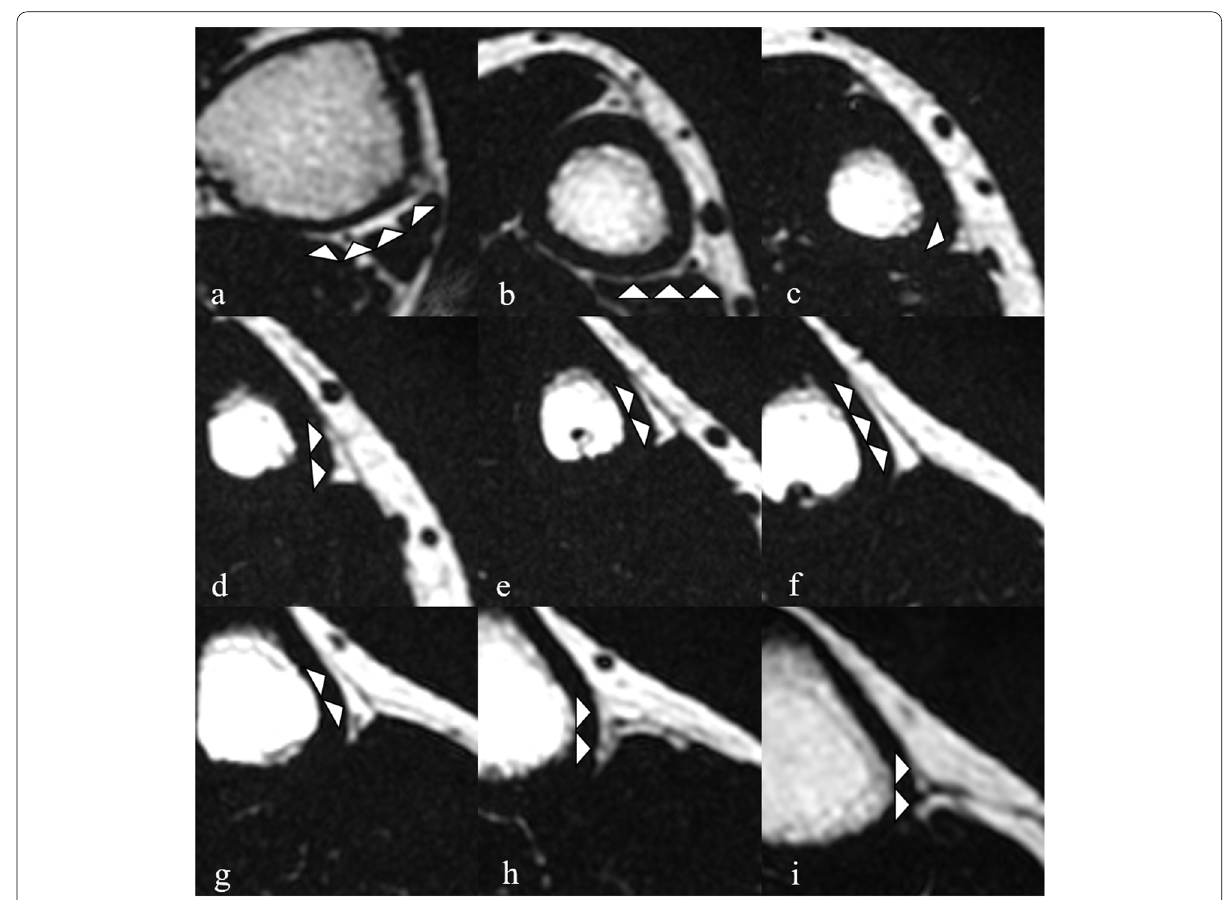
Fig. 3 A 22-year-old man. Adipose tissue morphology by slice levels on fat-only transverse plane images using LAVA-Flex. Images acquired at a : 3 cm; b : 6 cm; c : 9 cm; d : 12 cm; e : 15 cm; f : 18 cm; g : 21 cm; h : 24 cm; and i : 27 cm from the distal tip of the medial malleolus. These images are